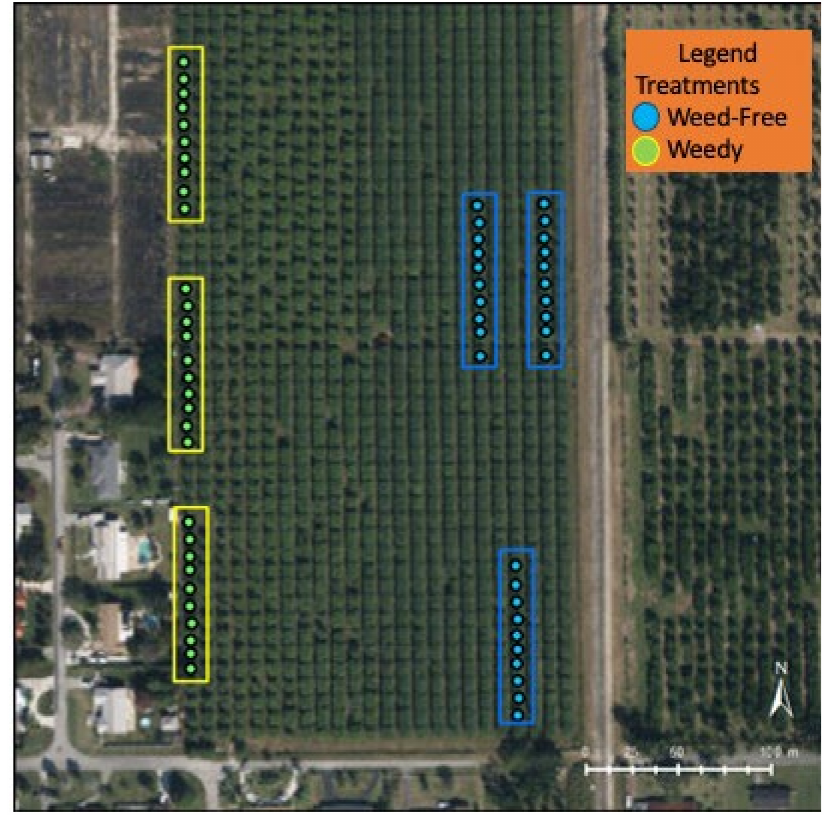
Figure 1. Map of weedy and weed-free trees on the farm in Homestead, FL,